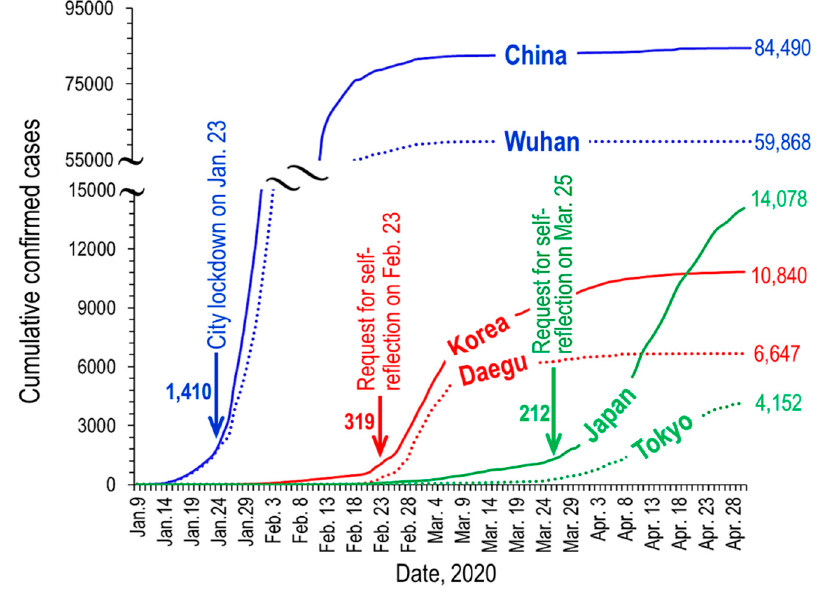
Figure 3. Timely variation of the cumulative status of COVID-19 in Wuhan/China, Daegu/Korea, and Tokyo/Japan.